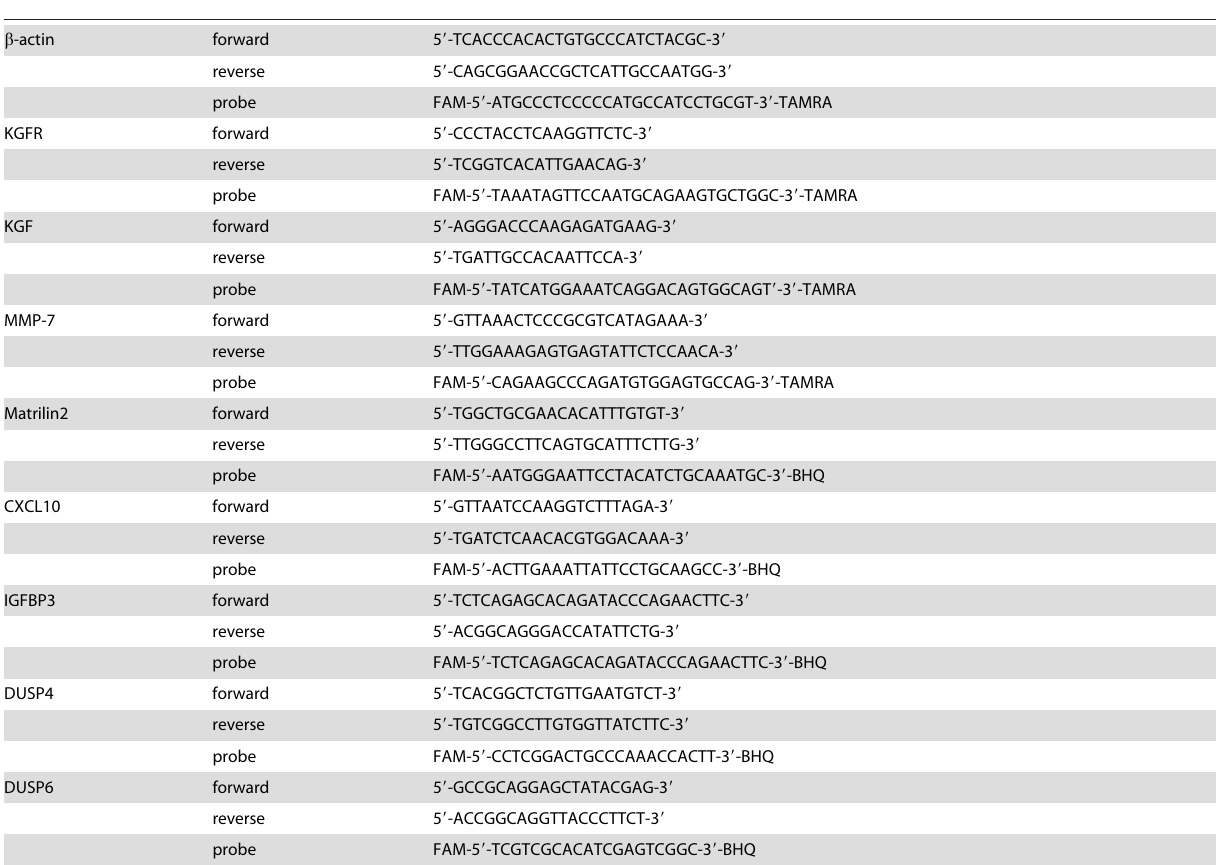
Table 3. Sequences of primers and probes used for quantitative real-time